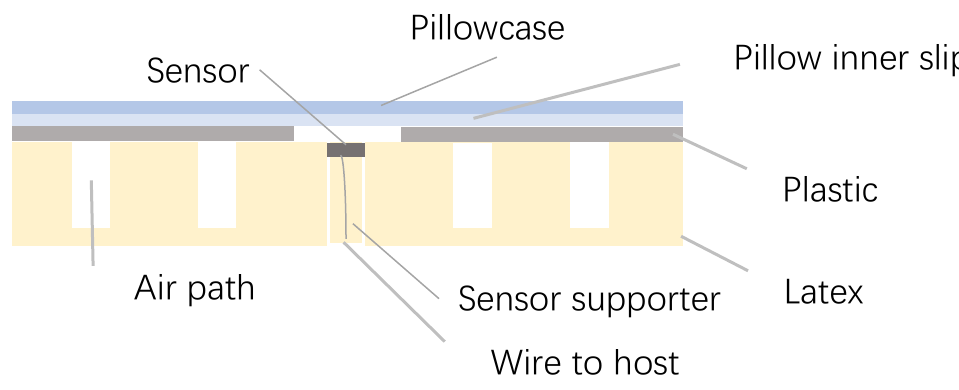
Figure 4. The sectional diagram of the “Smart Magic Pillow”.